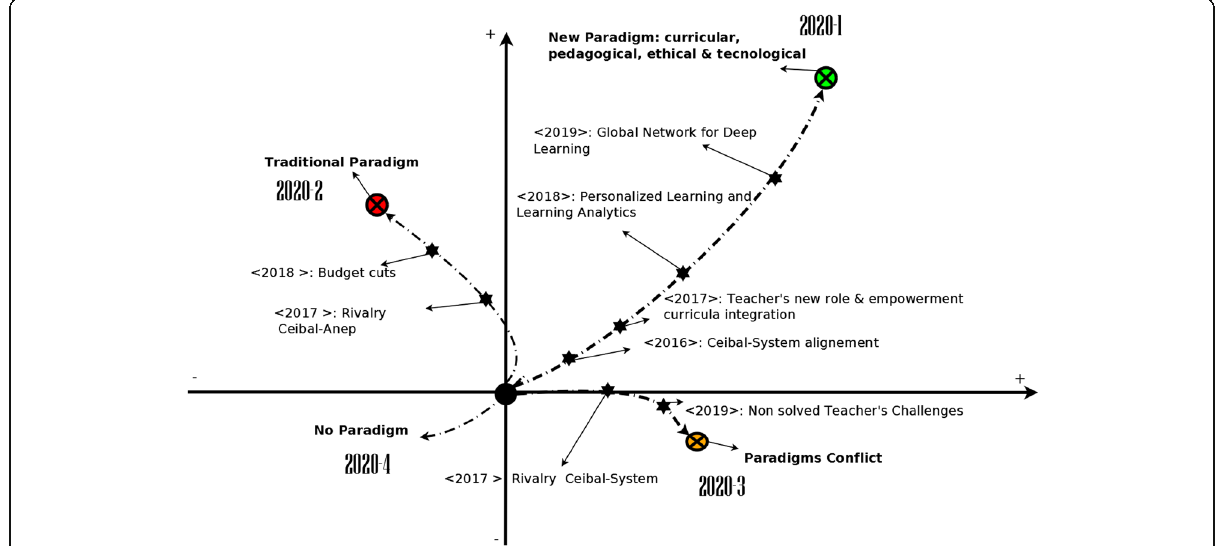
Fig. 5 Future scenarios for technology and education ( x — technology supply, y — technology